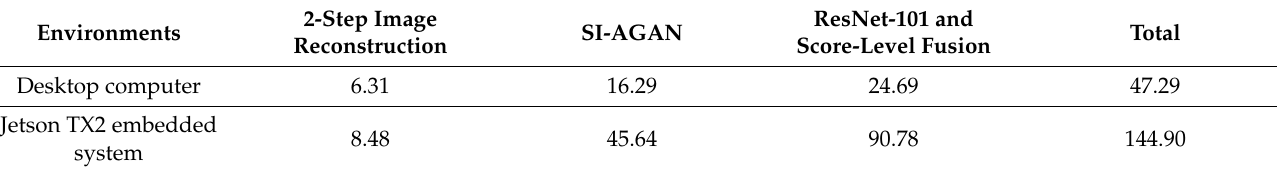
Table 19. Average processing time of our proposed method (unit: